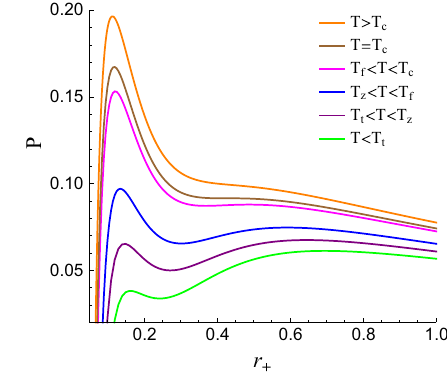
Fig. 1 P − r + diagram for different regions of temperature. At T = T c there is an inflection point which shows a second order phase transition betweenSBHandLBH,andblackholesarephysicallyindistinguishable for T > T c . For T f < T < T c ( T z < T < T f ), black holes undergo < T < T t z and black holes undergo the LBH–SBH–IBH phase transition in this region of temperature. There are LBH at T < T t and